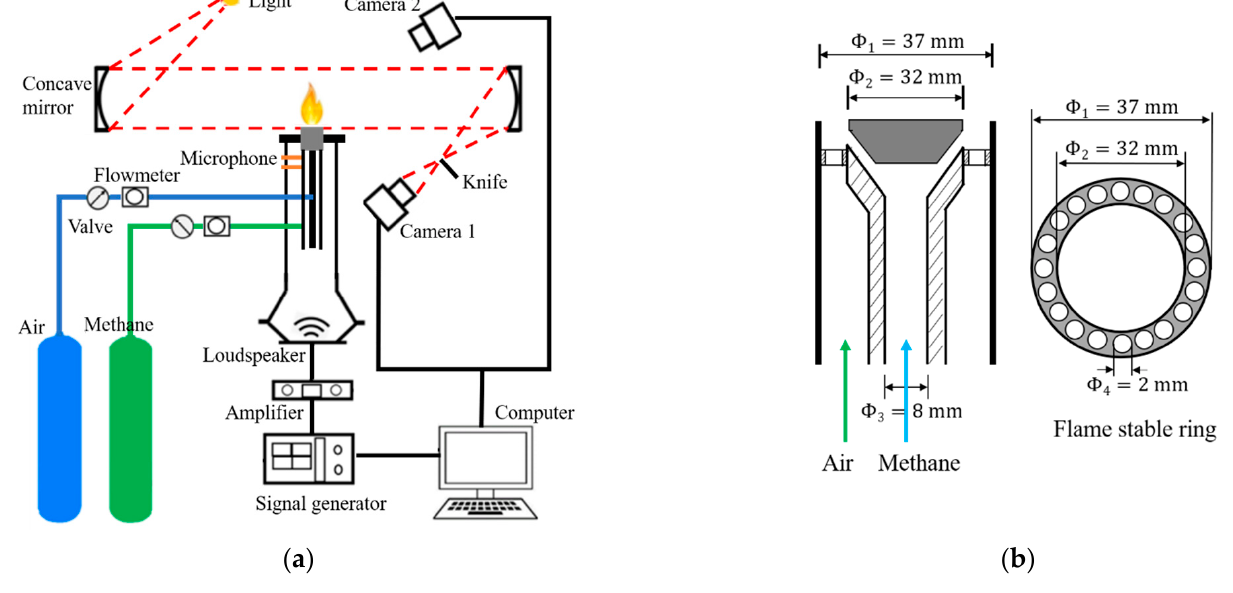
Figure 1. ( a ) Schematic of experimental system; ( b ) nozzle structure and parameters.